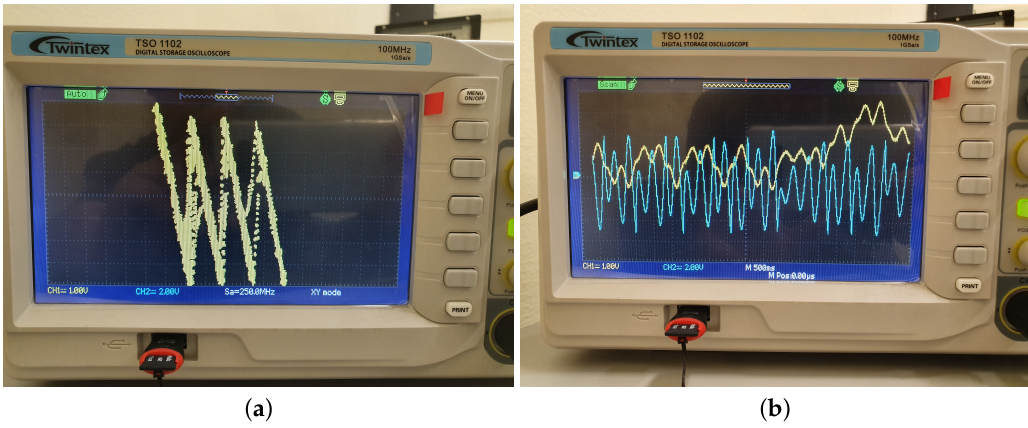
Figure 5. Acquired data from the master system: ( a ) Projection on the plane ( χ 1 , χ 3 ). ( b ) χ 1,3 vs t .